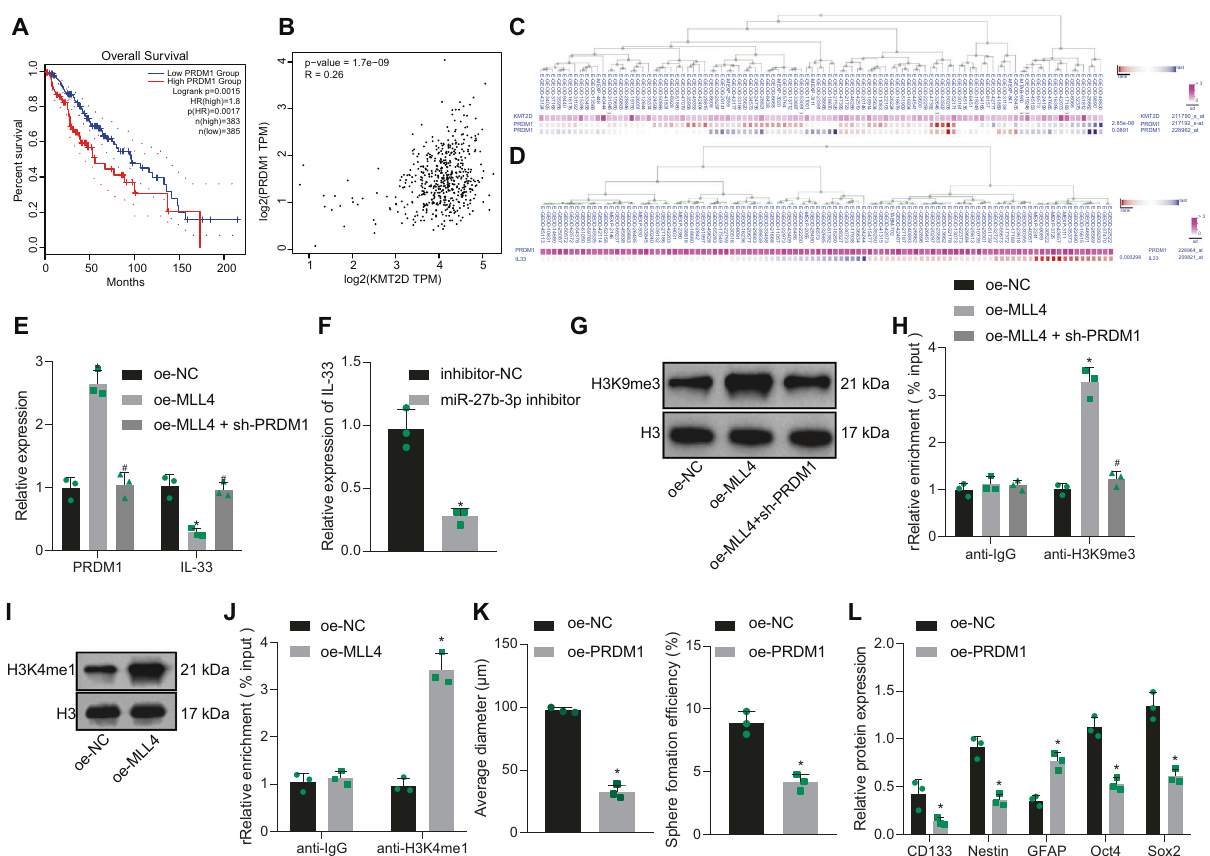
Fig. 6 miR-27b-3p increases the properties of GSCs by downregulating the MLL4/PRDM1/IL-33 axis. A Survival curve of GBM patients with high or low PRDM1 expression. B Correlation between the expression of MLL4 and PRDM1 in GBM analyzed by GEPIA. Co-expression of MLL4 and PRDM1 ( C ) as well as PRDM1 and IL-33 ( D ) analyzed by the MEM database (https://biit.cs.ut.ee/mem/index.cgi). PRDM1 ( E ) and IL-33 ( E , F ) expression in GSCs determined by RT-qPCR. H3K4me1 ( I ) and H3K9me3 ( G ) levels in GSCs measured by Western blot analysis. The relative levels of IL-33 ( H ) and PRDM1 ( J ) analyzed by ChIP assay. K The formation rate and diameter of spheres in GSCs. L Expression of stem cell- related protein CD133, Nestin, Oct4, Sox2, and GFAP in GSCs measured by Western blot analysis. * p < 0.05 vs. the oe-NC group or the inhibitor- NC group. # p < 0.05 vs. the oe-MLL4 group. Measurement data were depicted as mean ± standard deviation. Comparison of data between two groups was conducted by unpaired t test, while that among multiple groups by one-way ANOVA followed by Tukey ’ s post hoc test. Cell experiments were repeated three times